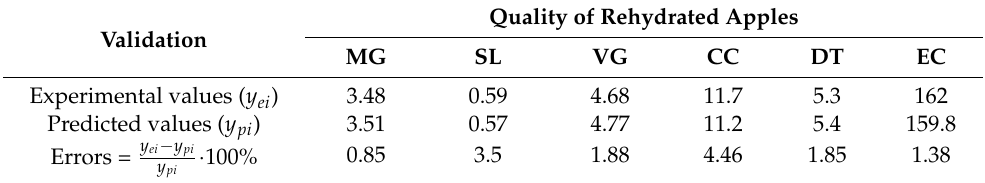
Table 4. Validation